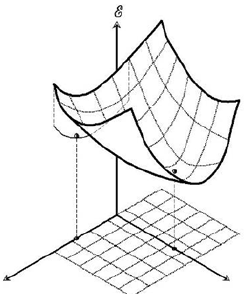
Figure 4: 3d plot of the energy  for u